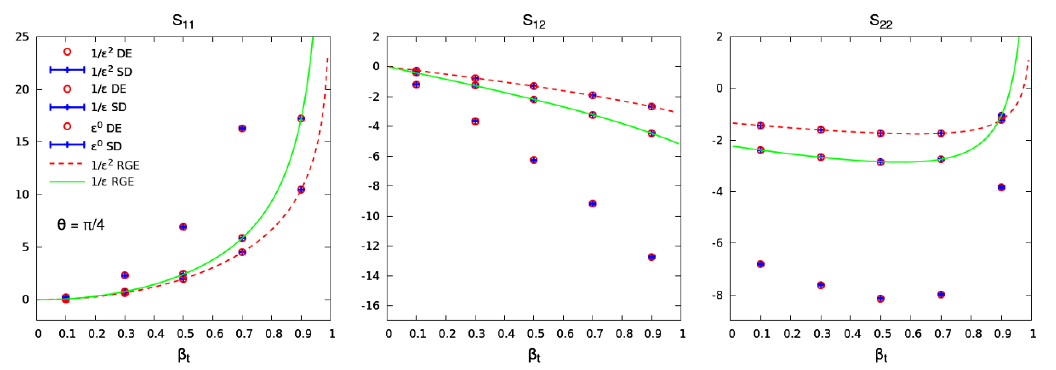
Figure 14 . Quark bubble contribution to the NNLO soft function in the q (cid:22) q channel. The plots correspond to three independent entries of the 2 (cid:2) 2 matrix determined for the (cid:12)xed values of (cid:18) = (cid:25)= 4 and L ? = 0. We see perfect agreement between RG prediction and the direct calculation